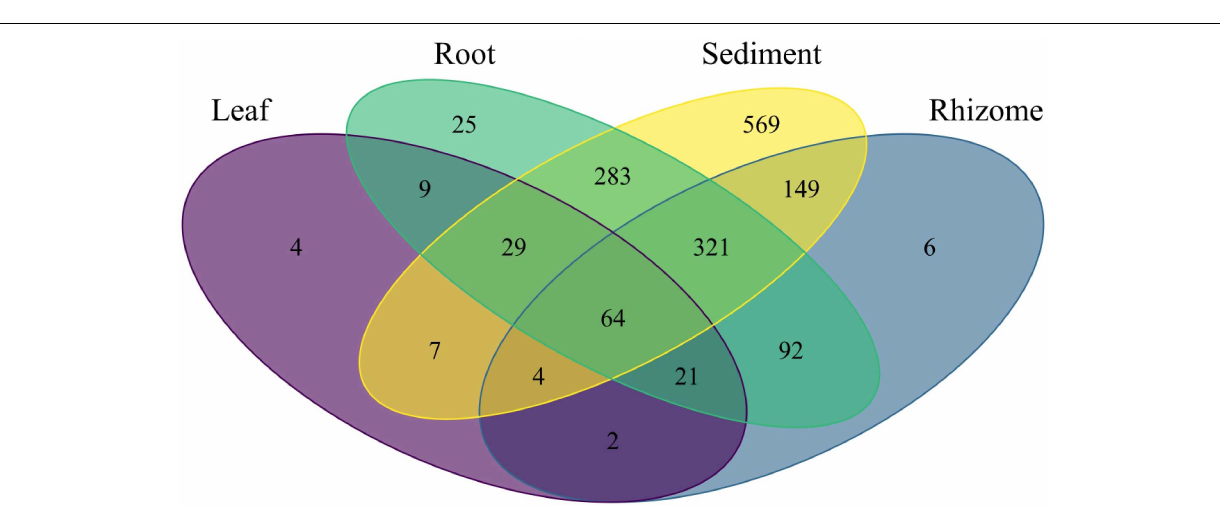
Frontiers in Marine Science |